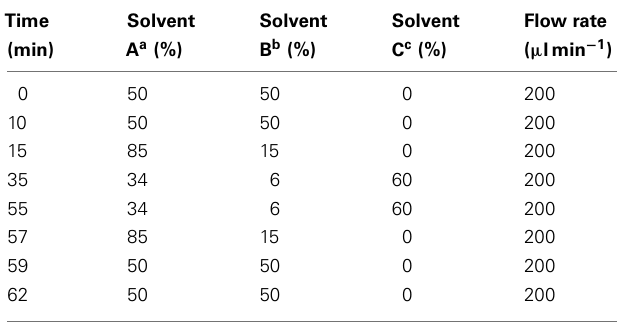
Table 1 |Ternary gradient system used for the RP-HPLC/MS 2 analysis of different galactolipid